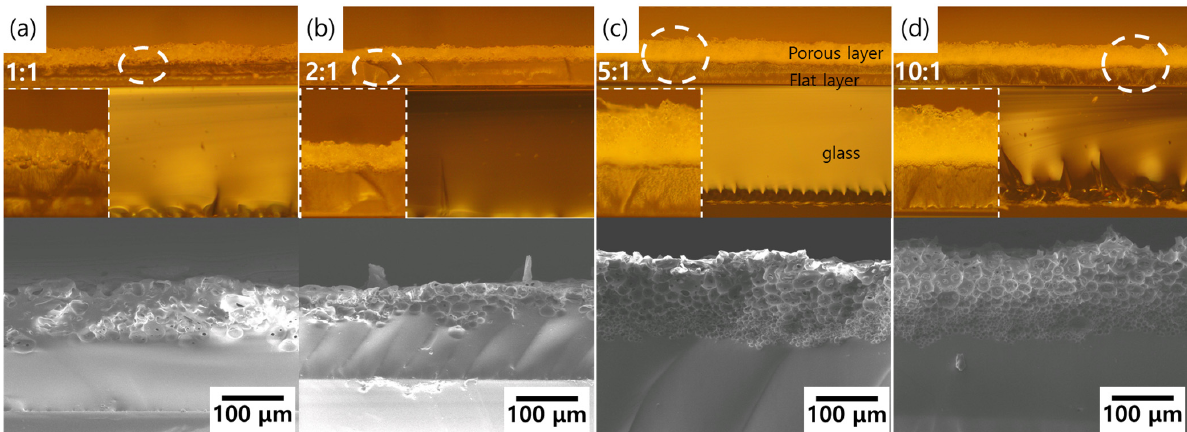
Figure 2. Optical and SEM images showing porous layer formed by high-pressure steam process with ( a ) 1:1 wt% (400 cp); ( b ) 2:1 wt% (800 cp); ( c ) 5:1 wt% (2100 cp); and ( d ) 10:1 wt% (3000 cp) uncured PDMS solution.